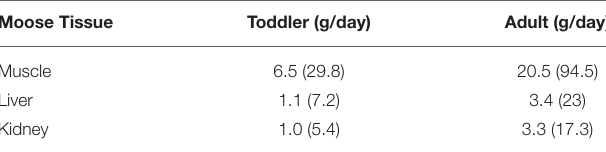
TABLE 1 | Mean (high) consumption rates of moose tissue used in the risk assessment (g/day). Moose